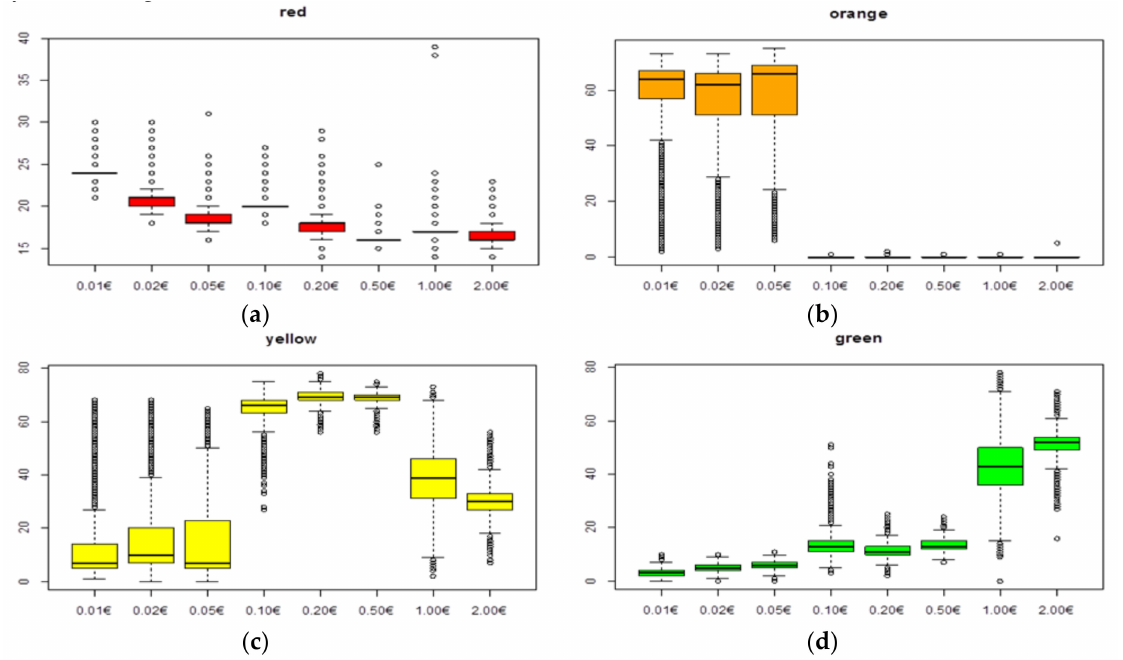
Figure 9. Box plot for: ( a ) red, ( b ) orange ( c ) yellow ( d ) green colours.